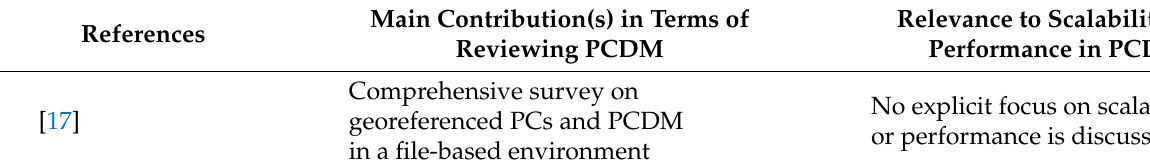
Table 1. Current reviews on PCDM and their relevance to scalability and